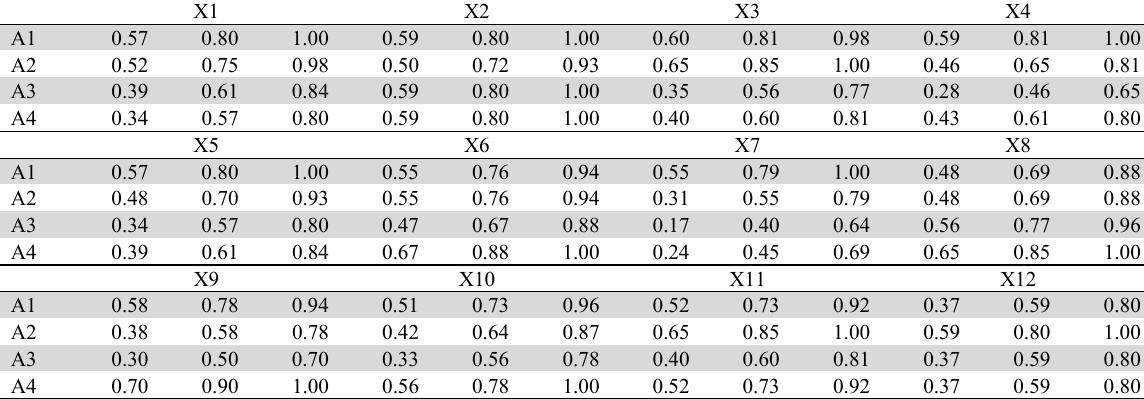
Normalized matrix for Kei Kecil Sub-District